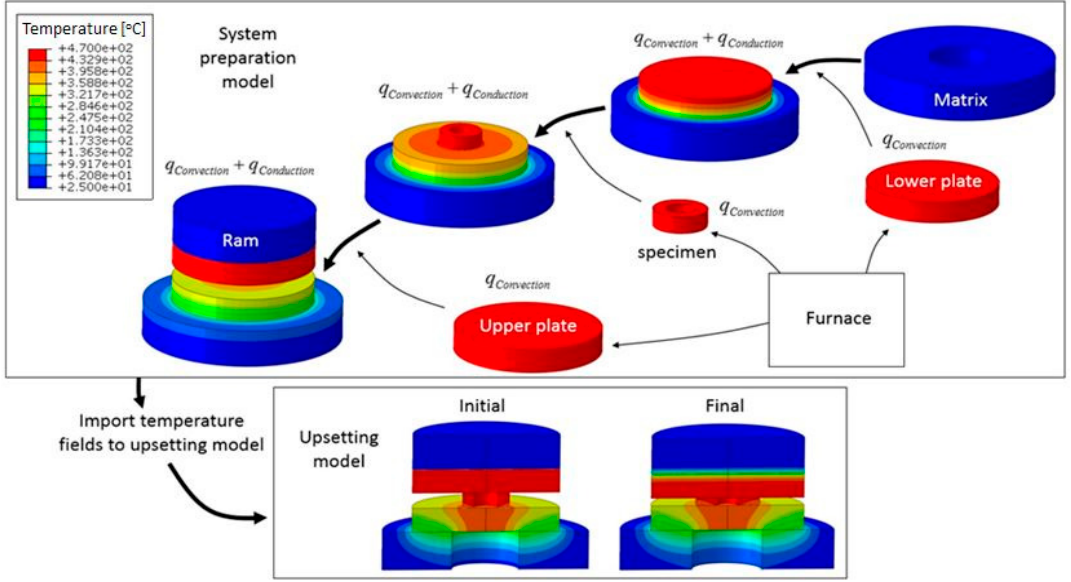
Figure 3. An example of the computational stages for simulating the system preparation of specimen R13.